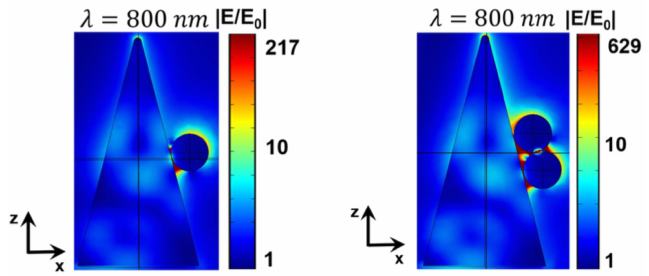
Figure 27. Electric field mapping | E ( z , x ) / E 0 | for Au nanoparticles (on the left, for one NP and, on the right, for two NPs, sphere diameter = 100 nm) placed on the lateral surface of a silicon cone for the resonant wavelength λ = 800nm, reprinted with permission from [18], the Optical Society